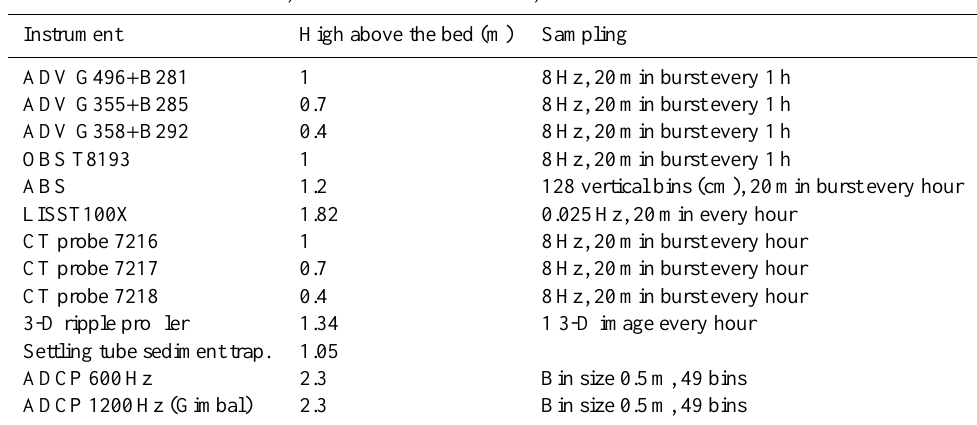
Table 2. Instrumentation in STABLE-III rig deployed in Hilbre Channel.